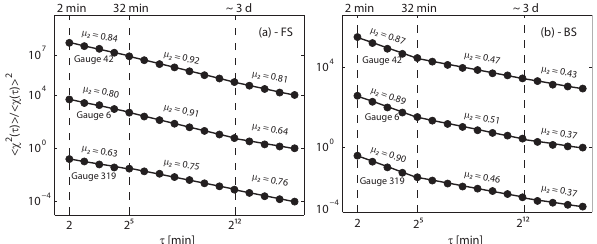
Fig. 6. Example of scaling regimes obtained by computing the in- termittency exponent µ 2 for gauges with IDs 42, 6, and 319 (shown in Fig. 1b), for (a) the FS and (b) the BS series. The slopes of the lines are estimates of µ 2 in Eq. (6). Arbitrary units on the y-axis are used in order to display results from different gauges in the same